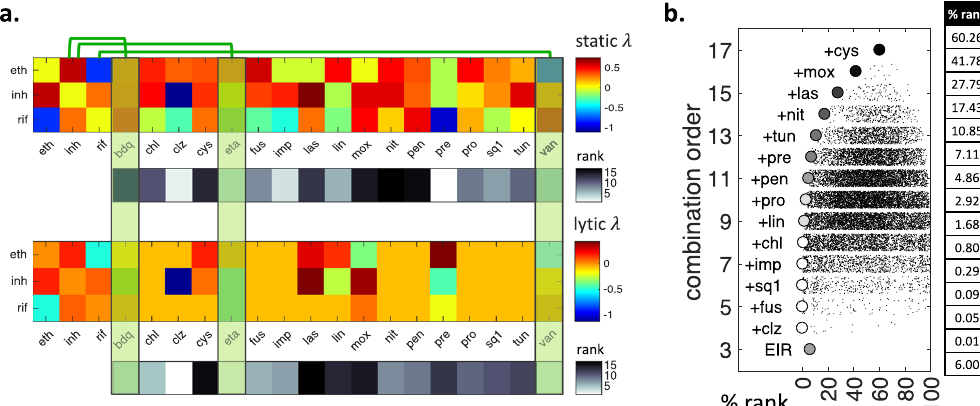
Figure 4. Improving the current M. tuberculosis treatment by adding new drugs. ( a ) At the top, static interactions of eth, inh and rif (EIR) with the other 17 drugs are shown. Green vertical rectangles indicate drugs that are similar with a member of EIR. inh is similar to bdq and eta, rif is similar to van. Therefore, bdq, eta and van are excluded from further consideration. The estimated static interaction score for each 4-order combination is ranked and shown in black-white. Pre and clz rank high among 4-order combinations that include EIR. At the bottom, lytic interactions for EIR with other 17 drugs are shown. Unknown interactions are shown in orange. The estimated lytic interaction score for each 4-order combination is ranked and shown in black-white. Clz ranks high in lytic synergy, however pre ranks low due to its antagonistic lytic interaction with eth. Therefore, clz emerges as the top ranked compound to complement EIR. ( b ) Relationship between combination order and rank% among all combinations including EIR. %rank for all combinations in each combination order is shown as a scatter plot jittered in y axis. The combination with best %rank in each order is indicated with a circle, with its color corresponding to its %rank among all possible combinations. EIR is the only 3-order combination and ranks at 6%. Addition of clz greatly improves the static and lytic synergy ranks of EIR, and 4-order combination EIR + clz is ranked at 0.01%. A 6-order combination involving EIR + clz + fus + sq1 ranks in the first